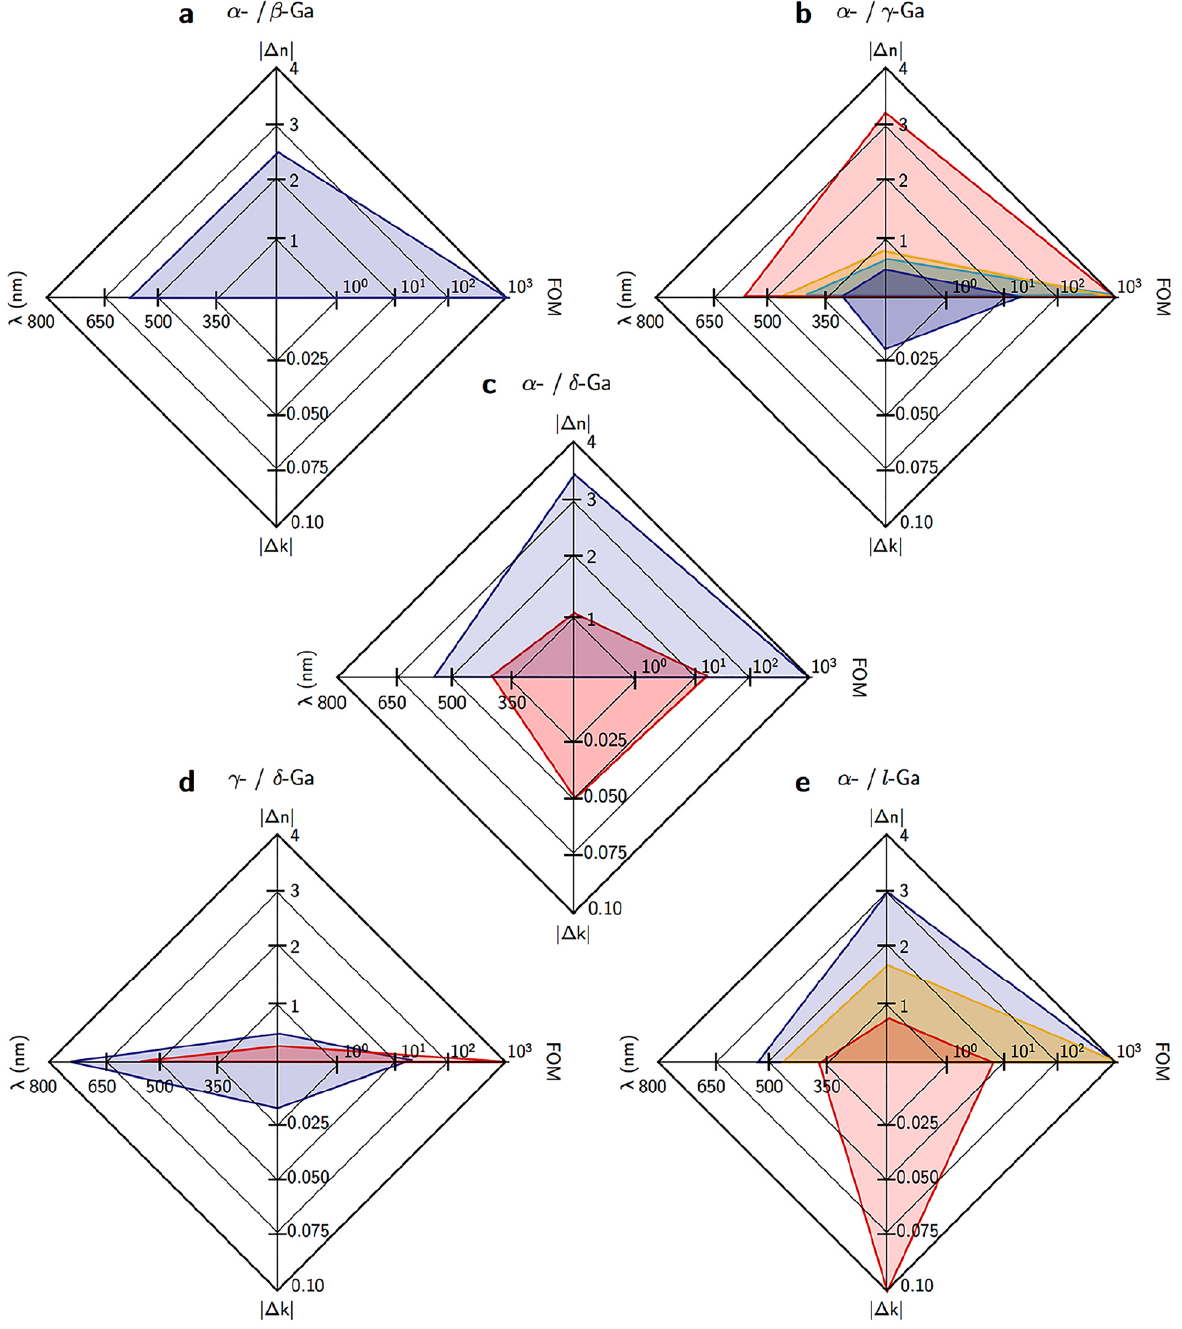
Figure7: Analysisofthefigure-of-merit(FOM)peaks.RadarplotsshowingthecharacteristicsoftheFOMpeaks(FOMvalue,peakwavelength, andrefractiveindexcontrast Δ n and Δ k ) appearinginFigure5forthetransitionbetween(a)alpha-/beta-Ga,(b) alpha-/gamma-Ga,(c)alpha-/ delta-Ga, (d) gamma-/delta-Ga and (e)